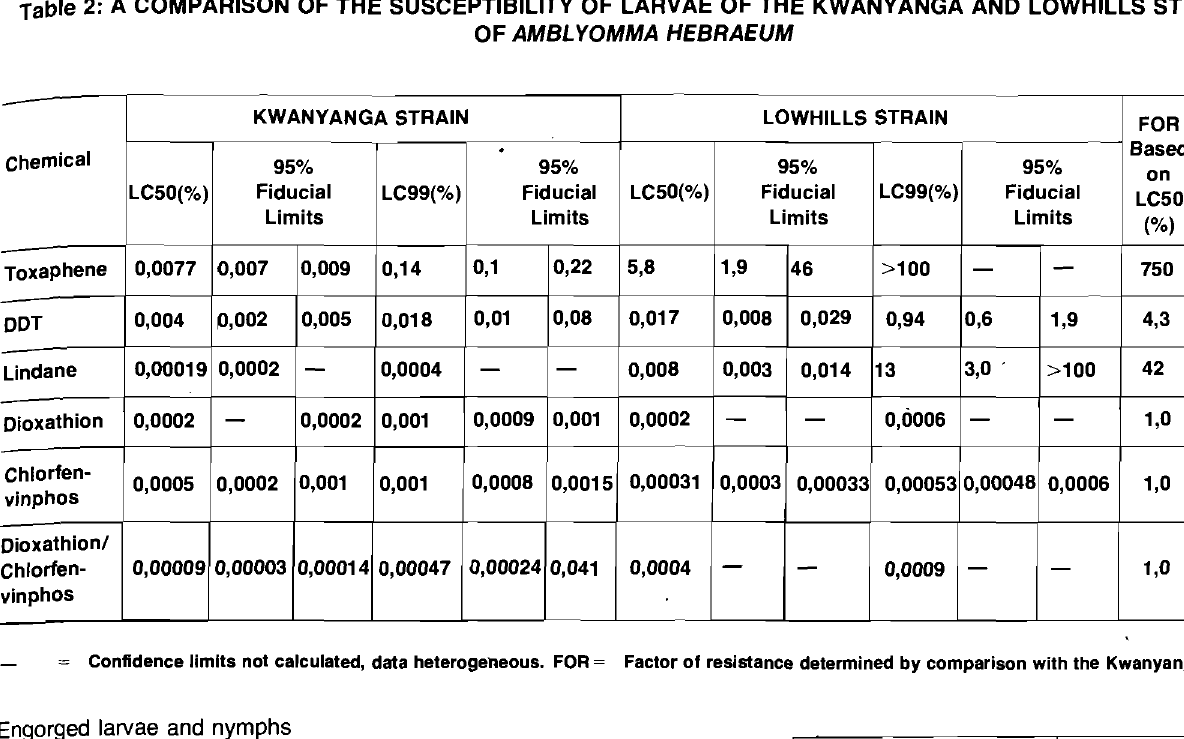
= Confidence limits not calculated, data heterogeneous. FOR = Factor of resistance determined by comparison with the Kwanyanga strain. Engorged larvae and nymphs